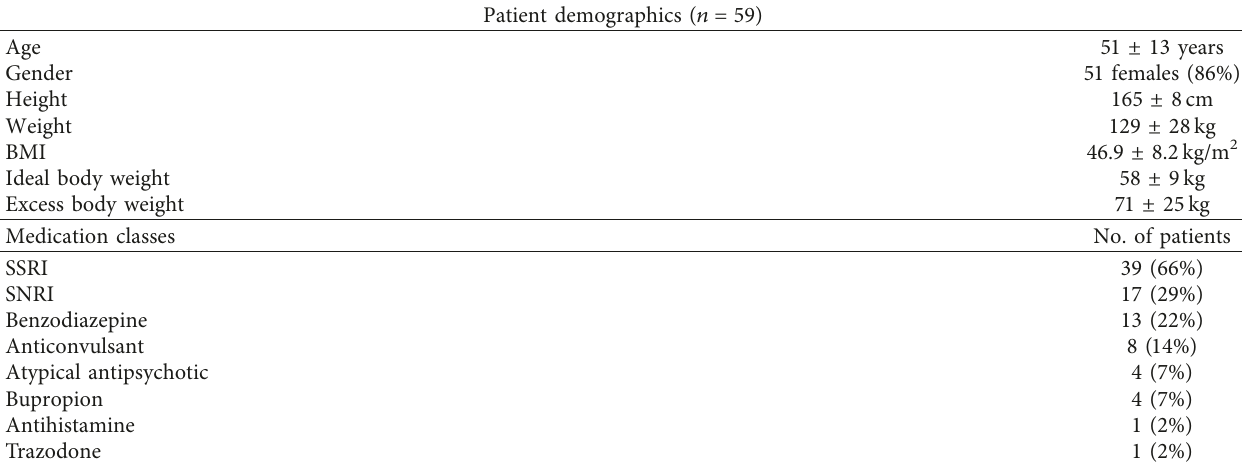
Table 1: Subject characteristics ( n � 59).